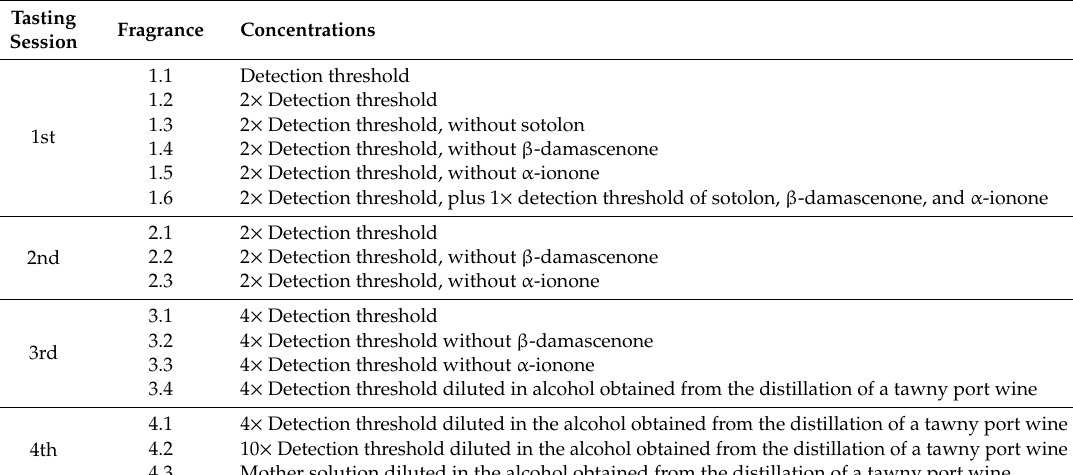
Table 2. Fragrance samples developed for the first four tasting sessions.